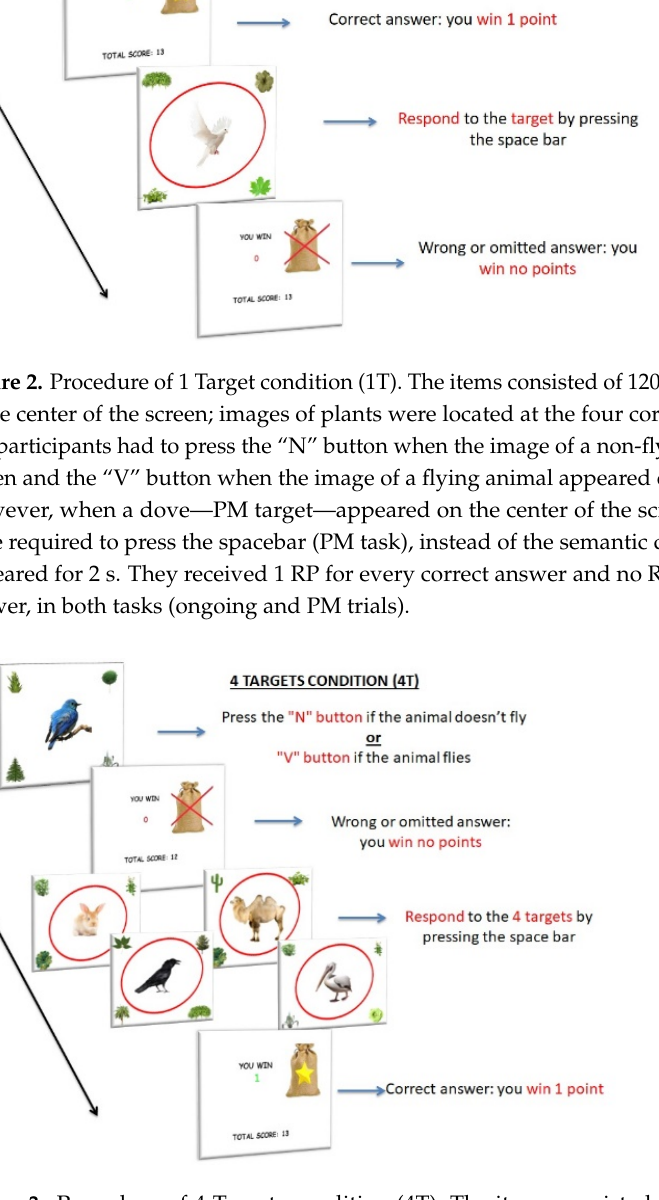
Figure 3. Procedure of 4 Targets condition (4T). The items consisted of 120 images of an animal located at the center of the screen; images of plants were located at the four corners of the screen. As in the BC, participants had to press the “N” button when the image of a non-flying animal appeared on the screen and the “V” button when the image of a flying animal appeared on the screen (ongoing task). However, when one of the four PM targets (rabbit, crow, camel, pelican) appeared at the center of the screen (12 trials), participants were required to press the spacebar (PM task), instead of the semantic decision task. Each stimulus appeared for 2 s. They received 1 RP for every correct answer and no RP for any wrong or omitted answer, in both tasks (ongoing and PM trials).